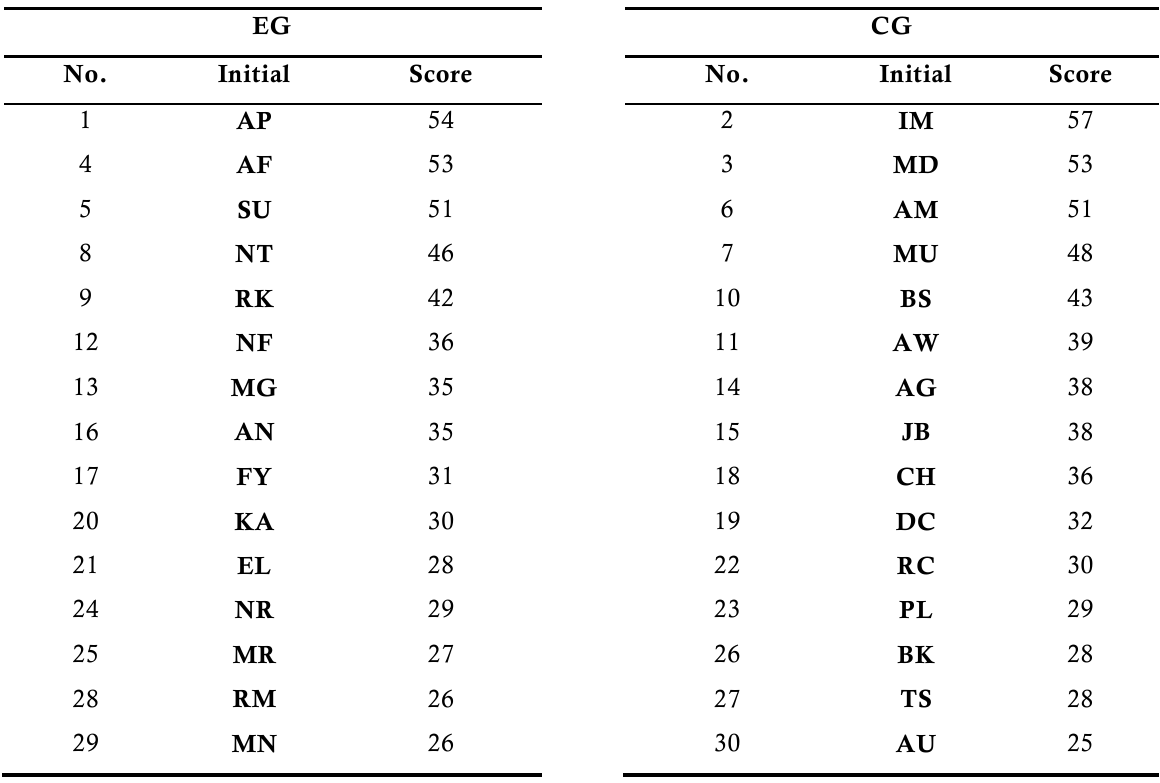
Table 3. Group distribution by means of the matching